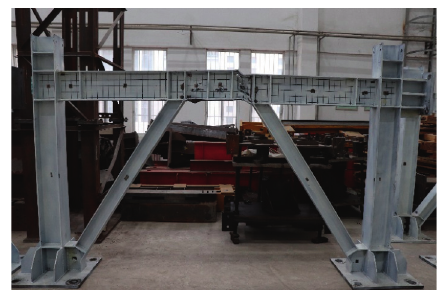
Figure 17: Failure modes of rigid-jointed